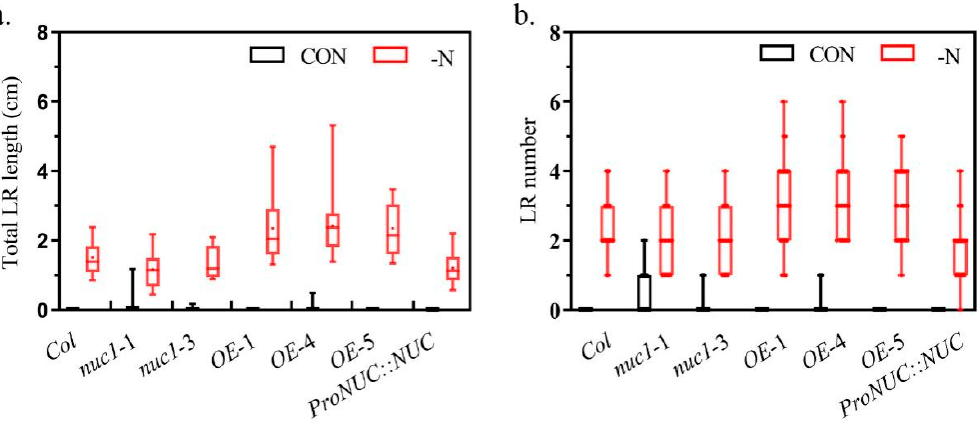
Figure 6. NUC overexpression promoted the development of N deficiency-induced lateral roots. ( a , b ): Total lateral root (LR)